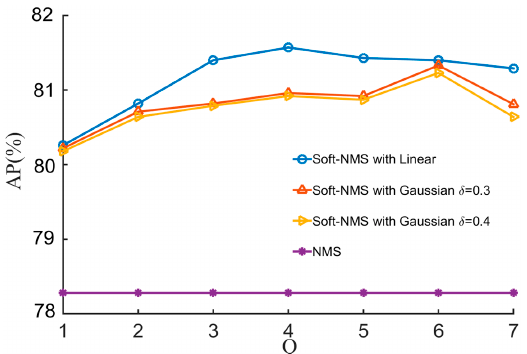
Figure 12. Detection effect of occluded preceding vehicles. Based on Equations (11)–(13), when Q = 1, Soft-NMS is nonoptimized, so when Q > 1, the result of Q = 1 is the comparison.